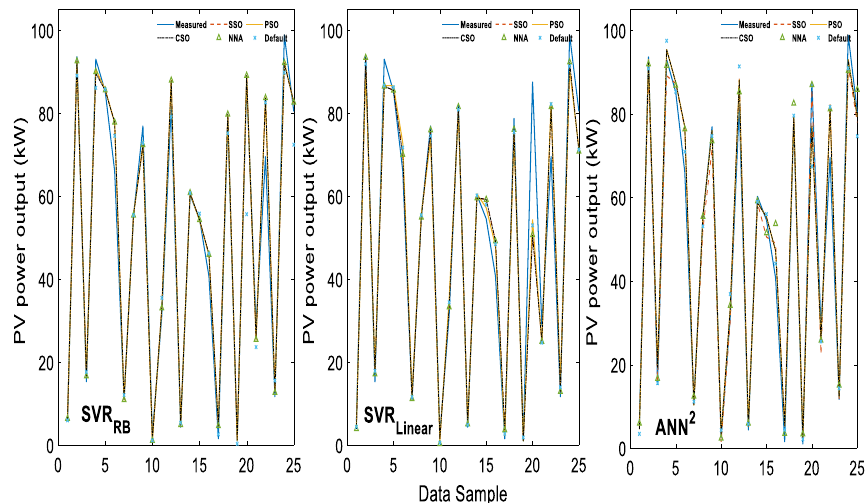
Fig. 10 The performance of the hybrid forecasting models with the optimization algorithms